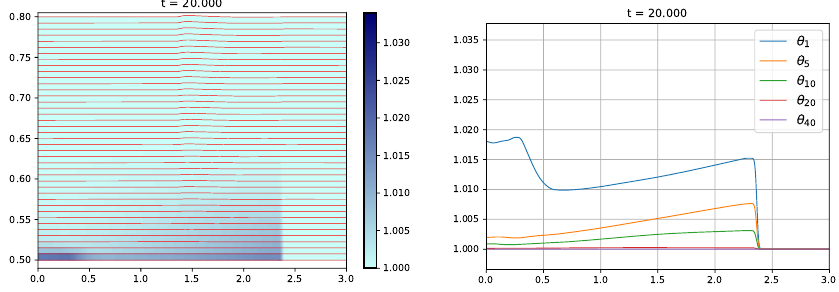
Figure 25. Evolution of the density driven current at t = 20 s.